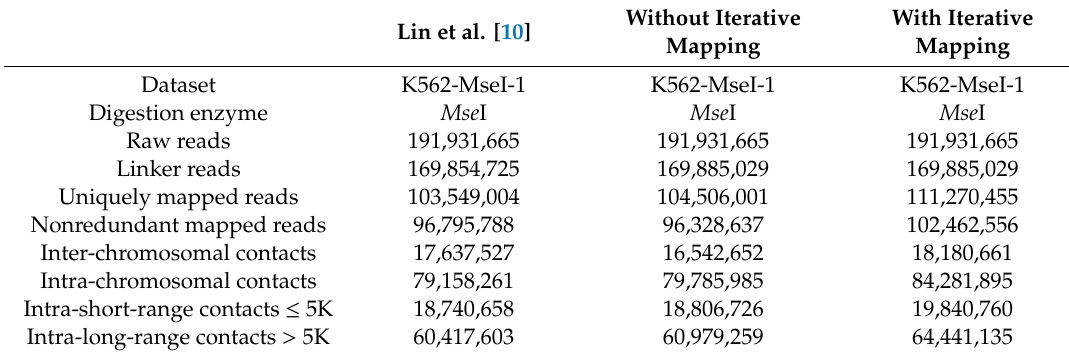
Table 4. Comparison of di ff erent strategies.